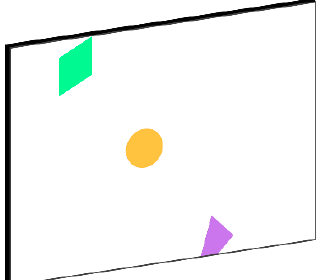
Figure 2. Illustration of defective regions in a CFRP specimen 1.